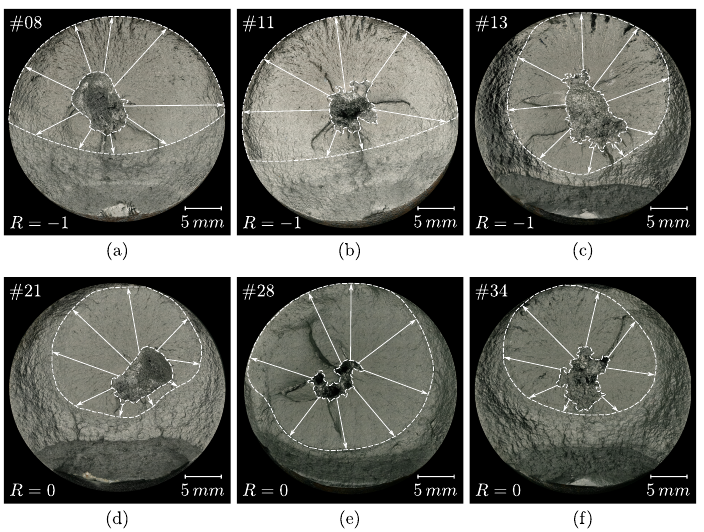
Figure 5. Fracture surfaces of selected defect-afflicted large–scale specimens: ( a – c ) Specimens #08, #11 and #13 tested at R = − 1; and ( d – f ) Specimens #21, #28 and #34 tested at R =